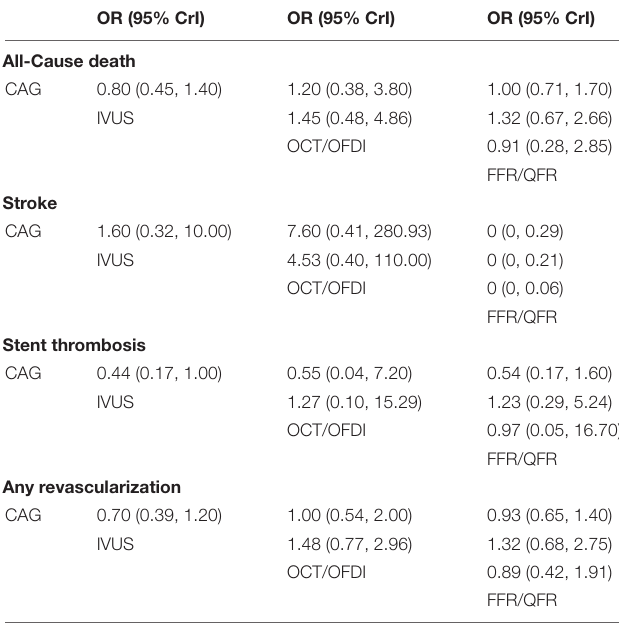
TABLE 3 | Comparisons of secondary outcomes among guidance modalities included in the network